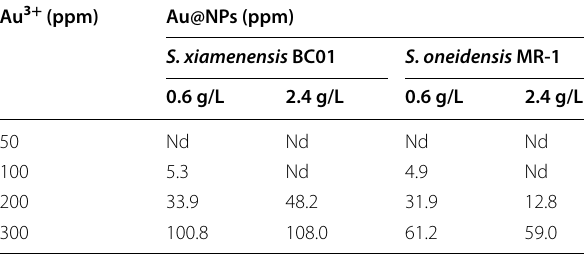
Table 2 The effect of gold ion concentration on Shewanella in Au@NP formation after 24 h